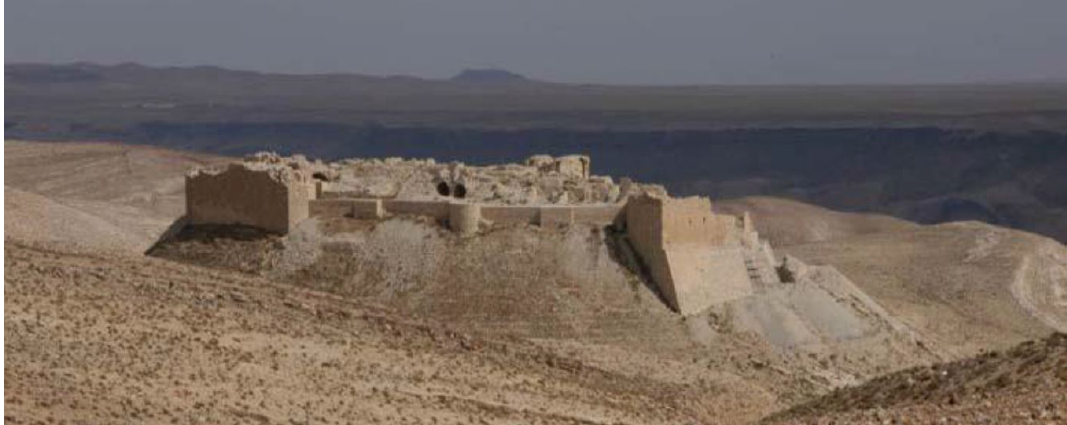
Figure 4. The castle of Shawbak (Ma’an region, Jordan).